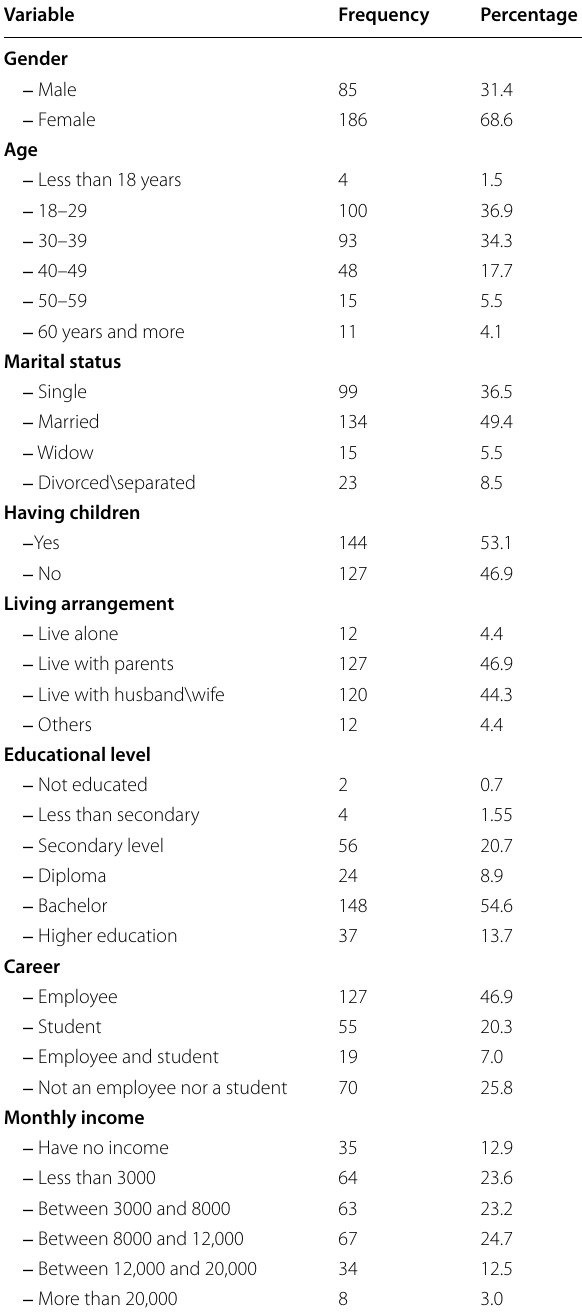
Table 1 Characteristics of informal caregivers in Saudi